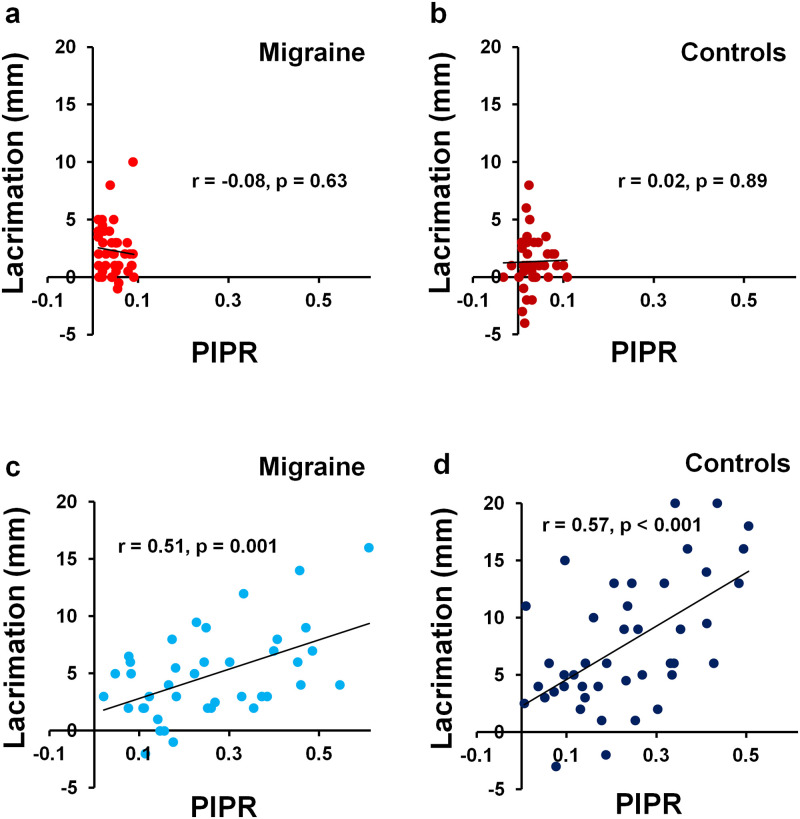
Correlations between light-induced lacrimation and PIPR responses.Raw data from individual trials was used, following red light stimulation for (a) participants with migraine and (b) controls, and following blue light stimulation for (c) participants with migraine and (d) controls.